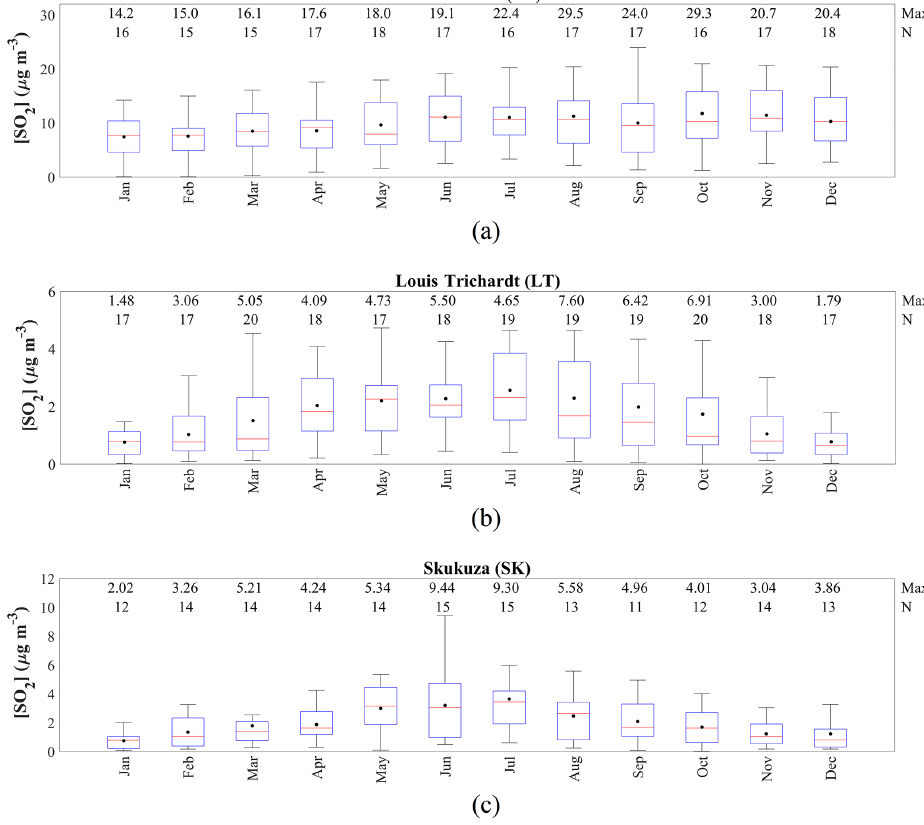
Figure 3. Monthly SO 2 concentrations measured at (a) AF from 1997 to 2015, (b) LT from 1995 to 2015 and (c) SK from 2000 to 2015. The red line of each box represents the median; the top and bottom edges of the box represent the 25th and 75th percentiles, respectively; the whiskers are ± 2 . 7 σ (99.3% coverage if the data have a normal distribution); and the black dots represent the averages. The maximum concentrations and the number of measurements ( N ) are presented at the